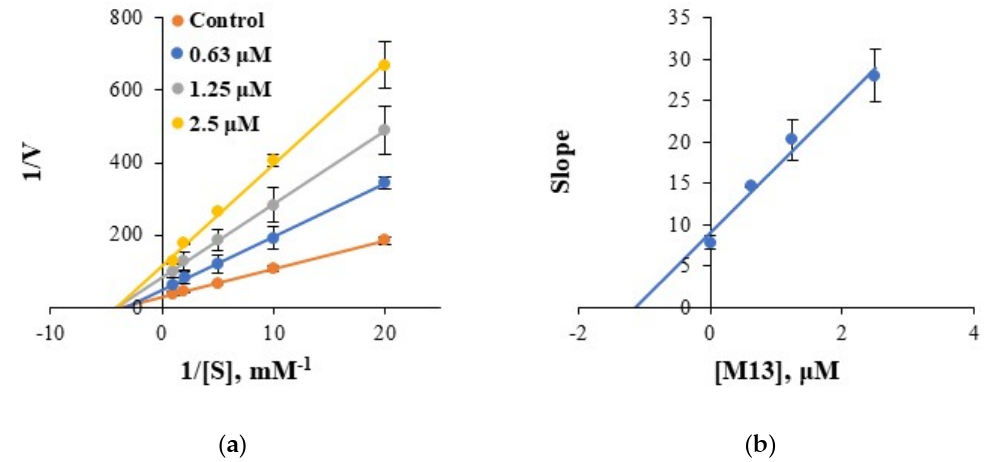
Figure 3. Lineweaver–Burk plots for BChE inhibition by M13 ( a ) and its secondary plot ( b ) of the slopes vs. inhibitor concentrations.